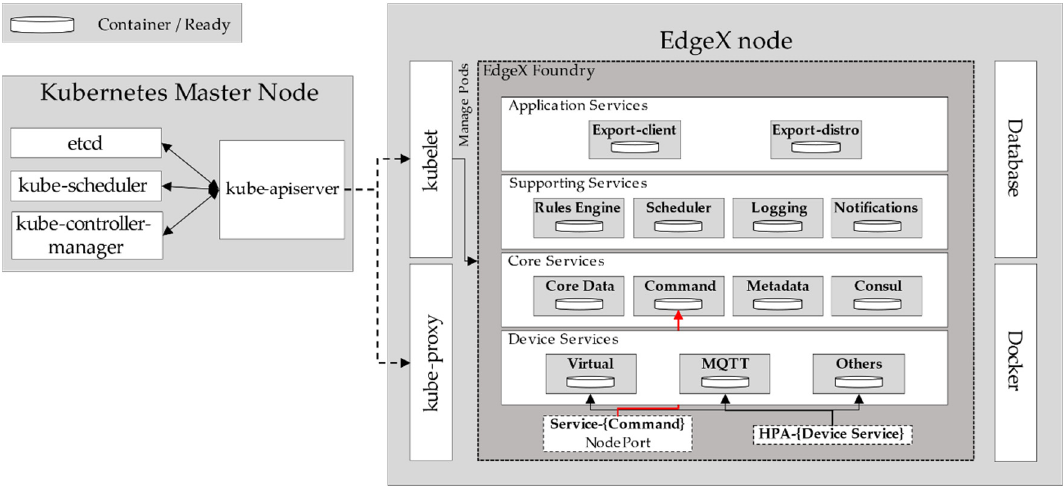
Figure 2. EdgeX over Kubernetes architecture.